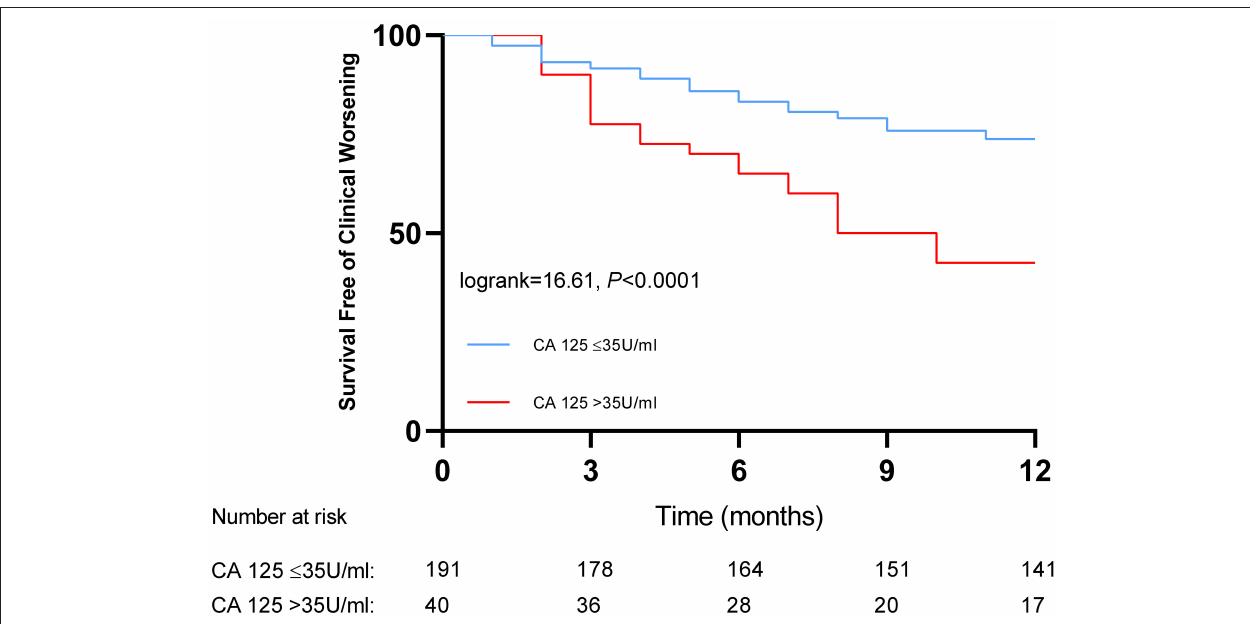
FIGURE 2 | Kaplan-Meier curves for patients with pulmonary hypertension classified by baseline serum levels of carbohydrate antigen 125.